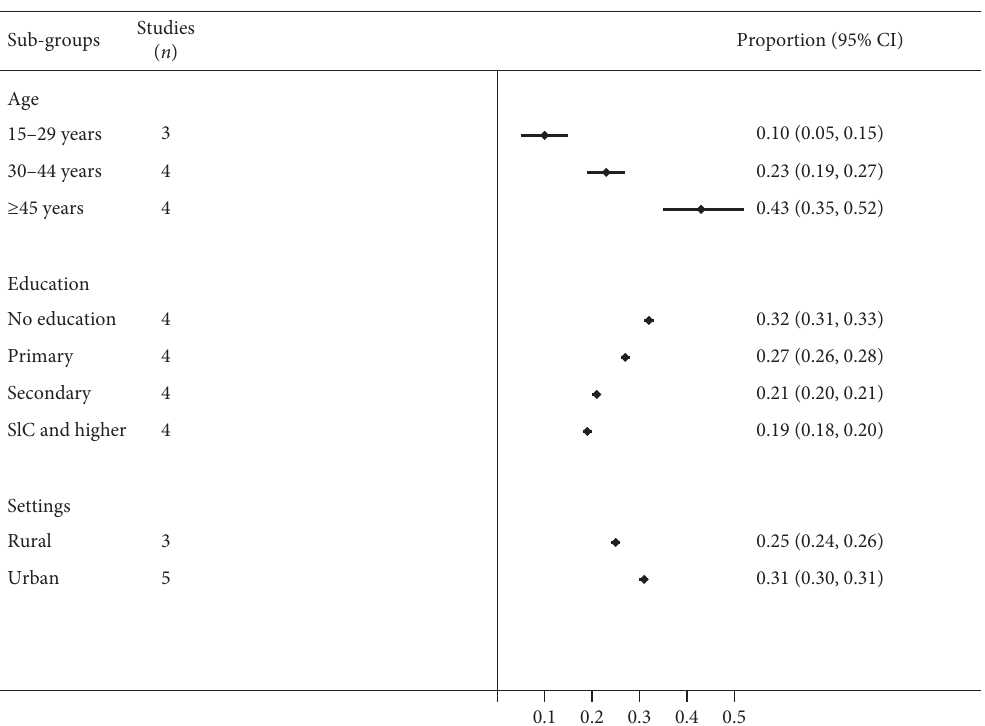
Figure 2: Prevalence of hypertension by subgroups in the period 2016–2020.